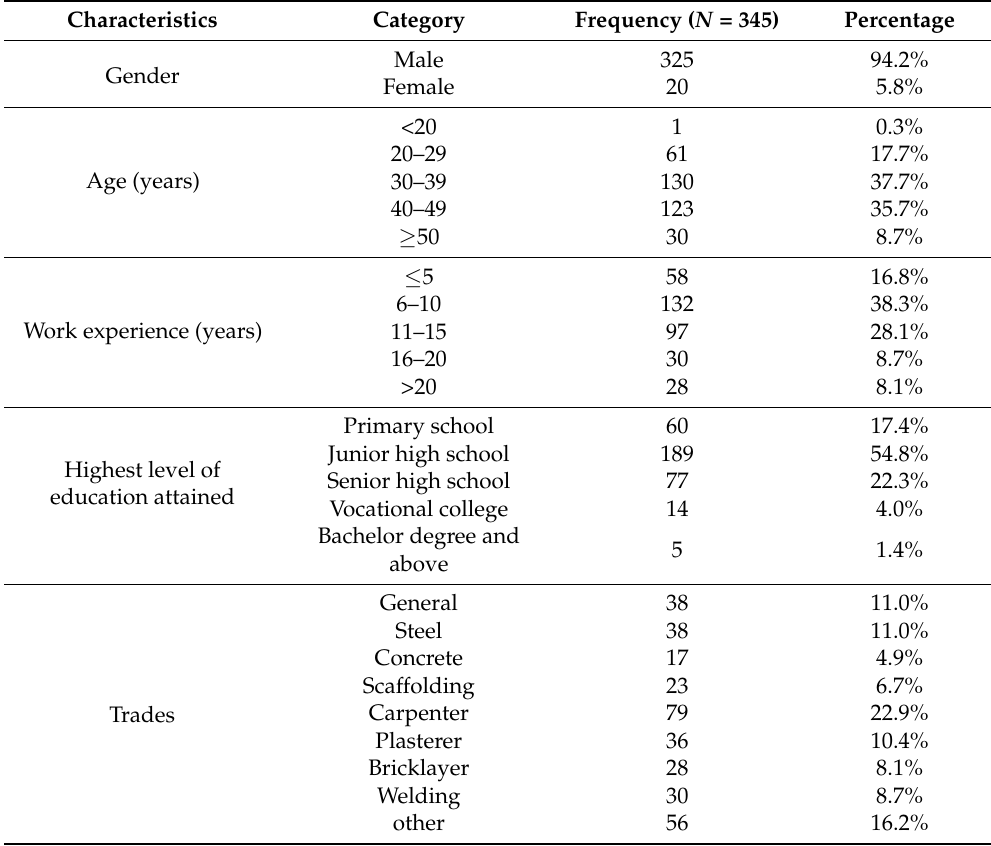
Table 1. Demographic characteristics of